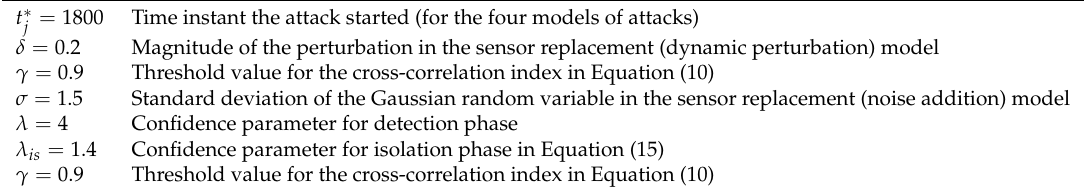
Table 6. Parameters of the proposed solution and attack models.